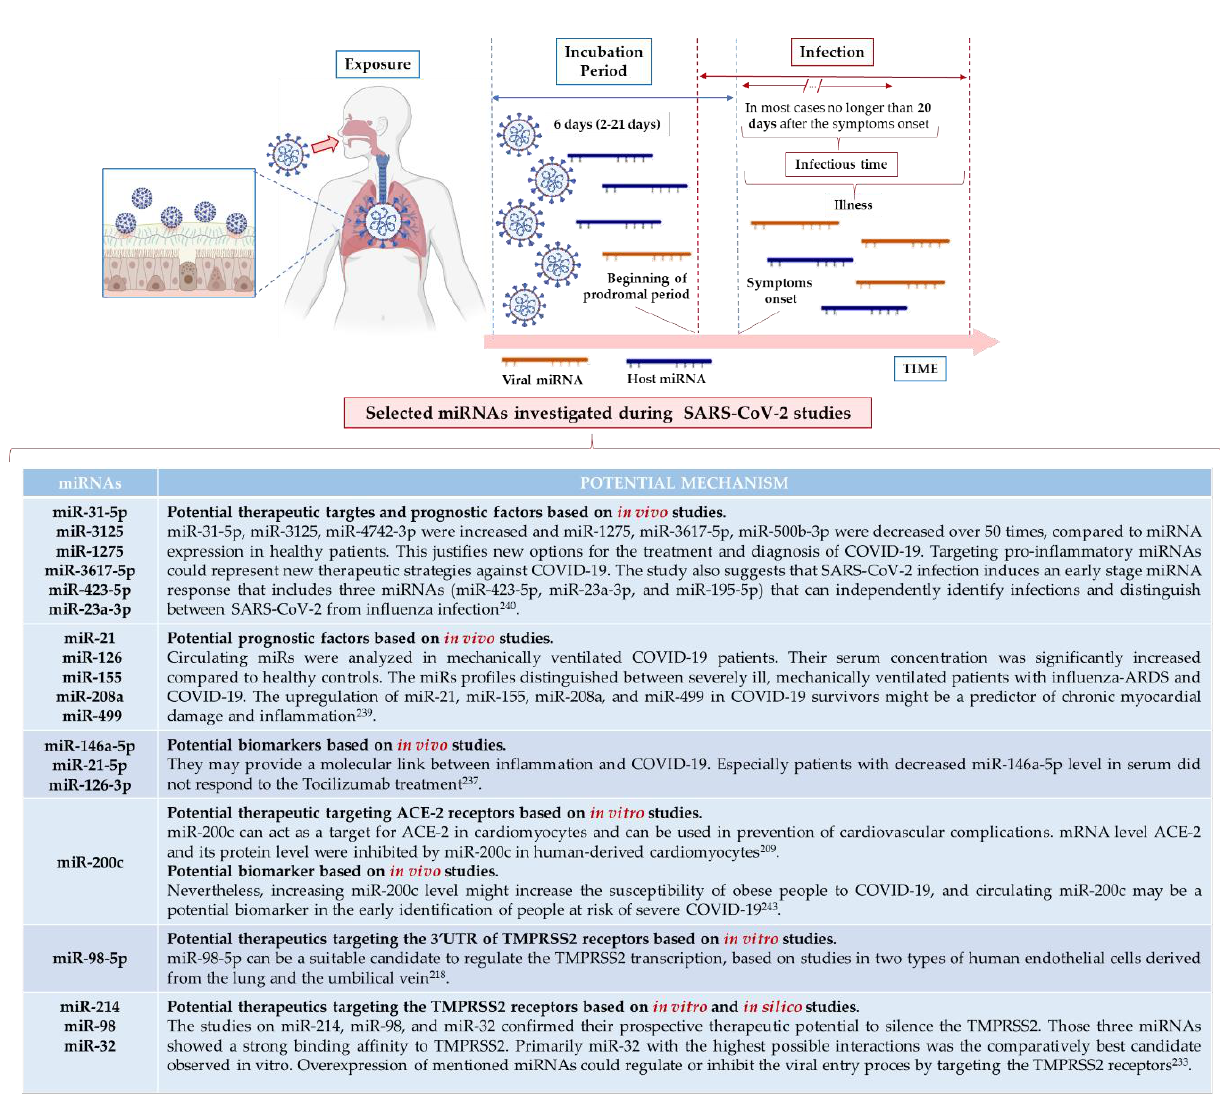
Figure 6. microRNAs alterations during SARS-CoV-2 infection in in silico, in vitro, and in vivo studies and their potential mechanisms of action. After exposure, the viral infection usually goes through three stages: (1) The incubation period, in which the pathogen is present and multiplies, but the patient shows no symptoms until the onset of the symptoms, and the infectious period starts before the symptom onset and might be extended in patients with chronic comorbidities; (2) the prodromal period, occurring after the incubation period, in which the pathogen continues to multiply and cause not-specific, too-general symptoms to indicate a disease, such as pain, fever, soreness, and swelling, typically resulting from the immune response; and (3) the actual period of illness, where the symptoms are most severe and obvious [199,200]. Most adults are likely to remain contagious up to 20 days after the onset of symptoms. However, there have been reports of people shedding a replication-competent virus for more than 20 days due to severe immunosuppression [201–205]. Thus, the released miRNAs of both the host and viral miRNAs can reflect the disease stage and provide important clinical information, especially when the causative pathogen is difficult to detect. SARS- CoV-2 can cause asymptomatic, mild, and severe diseases. Circulating miRNAs might differentiate these stages and their final prognosis [206].